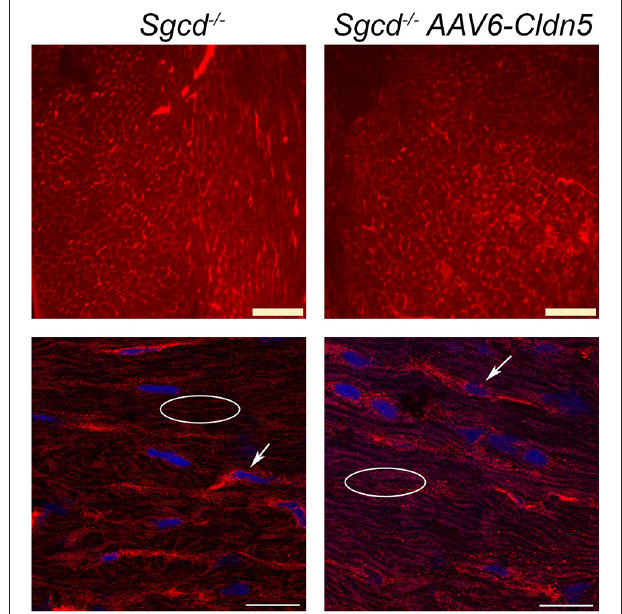
FIGURE 5 | Claudin-5 localization in Sgcd − / − hearts. Representative epifluorescence widefield (top) and confocal (bottom) images of claudin-5 immunofluorescence staining of transverse heart sections from Sgcd − / − and Sgcd − / − AAV6-Cldn5 treated mice. Bright claudin-5 staining of endothelial cells can be observed in hearts from both groups of mice (arrows). Claudin-5 localization in cardiomyocytes can be observed in a typical normal pattern of longitudinal striations in hearts from both groups of mice (ovals). Bars = 100 µ m (top) and 20 µ m (bottom)